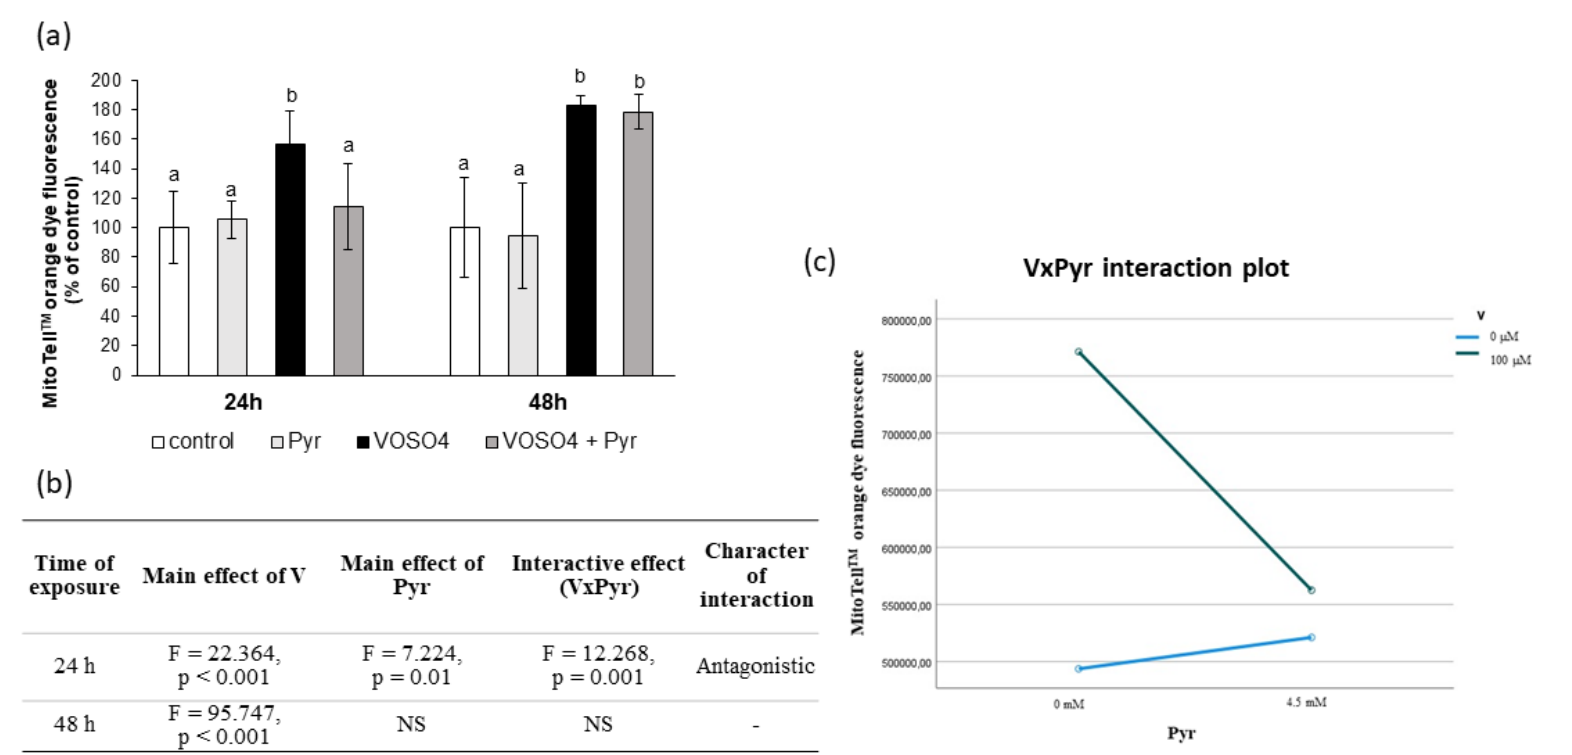
Figure 4. Effects of vanadium and/or pyruvate on MMP in CHO-K1 cells detected with the MitoTell staining method. The cells were incubated in DMEM/F12 medium without (control) or with 100 μM VOSO 4 in the presence or absence of sodium pyruvate (Pyr) (4.5 mM) for 24 h and 48 h. ( a ) MMP on the basis of MitoTell orange dye fluorescence emissions expressed in percentage. Data represent the mean ± SD derived from 3 independent experiments each performed at least in triplicates. Means at the same time point followed by a common letter are not significantly different. Data were analysed by one-way ANOVA followed by Tukey’s post hoc test, ( b ) Results of the two-way ANOVA analysis of MitoTell orange fluorescence emissions after 24- and 48-h exposure to V (as VOSO 4 ) and Pyr (pyruvate); NS: no significant effect; ( c ) interaction graph illustrating antagonistic interaction between V and Pyr for MMP after 24-h incubation.